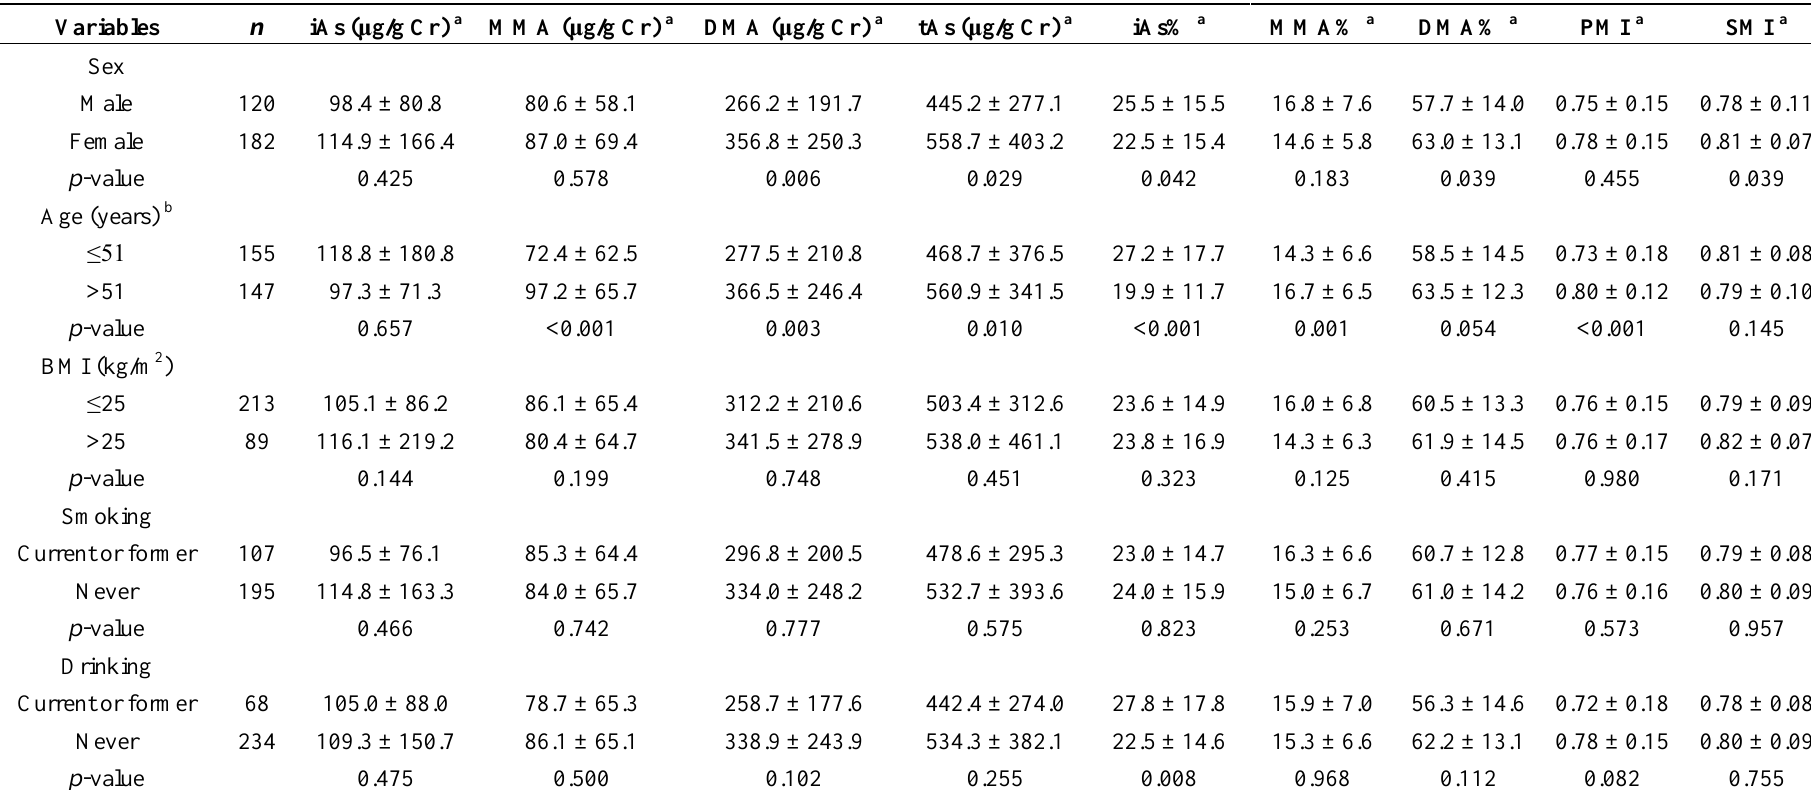
Table 2. Differences of urinary arsenic species and methylation indices between